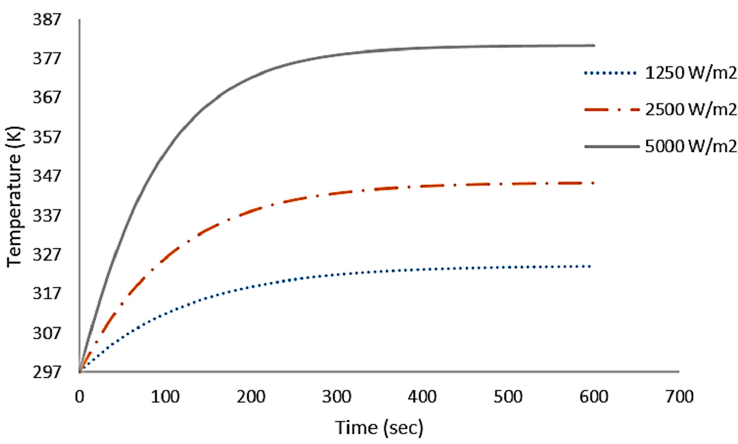
Figure 6. Transient variation of the heat sink temperature under three different heat fluxes.